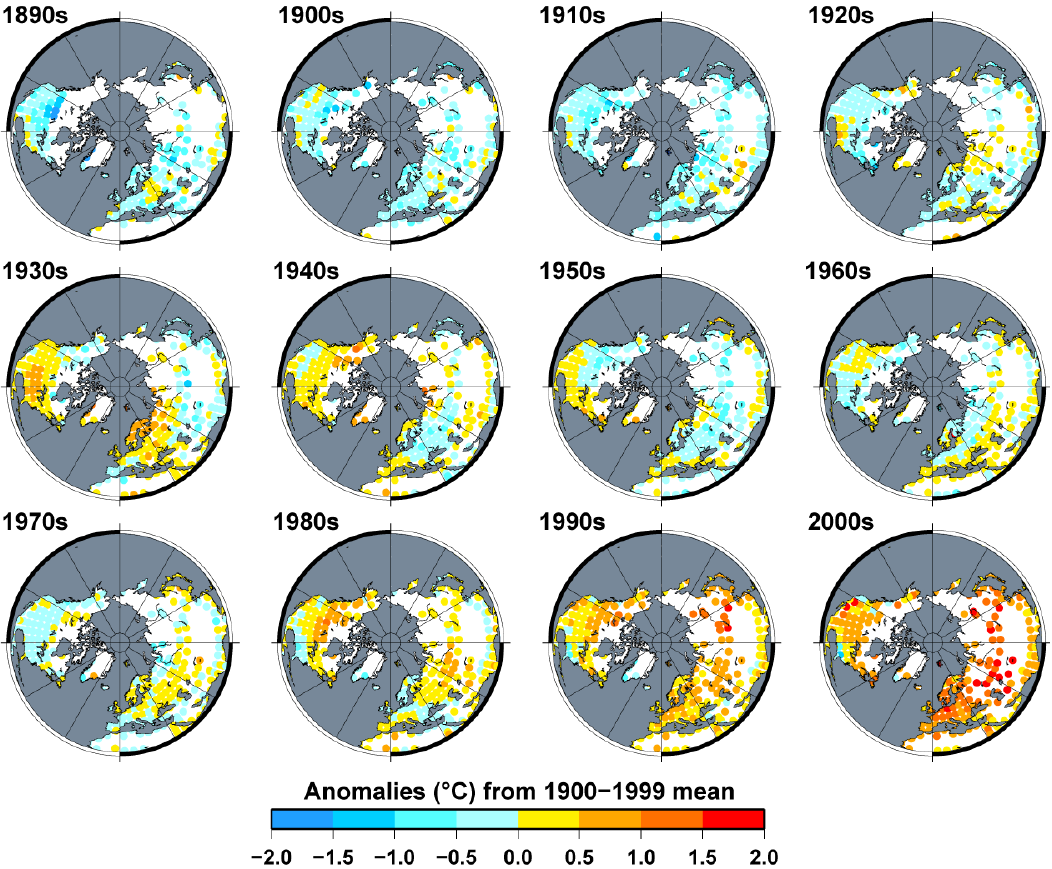
Fig. C1. Maps of decadal mean temperature anomalies (in ◦ C) from the 1900–1999 mean, for all NH land grid boxes in the HadCRUT3 dataset (Brohan et al., 2006) having at least 80% complete monthly data. The labels 1890s and 1900s etc., denote the mean for the period 1890–1899 and 1900–1910 etc., grid boxes over ocean areas are masked.